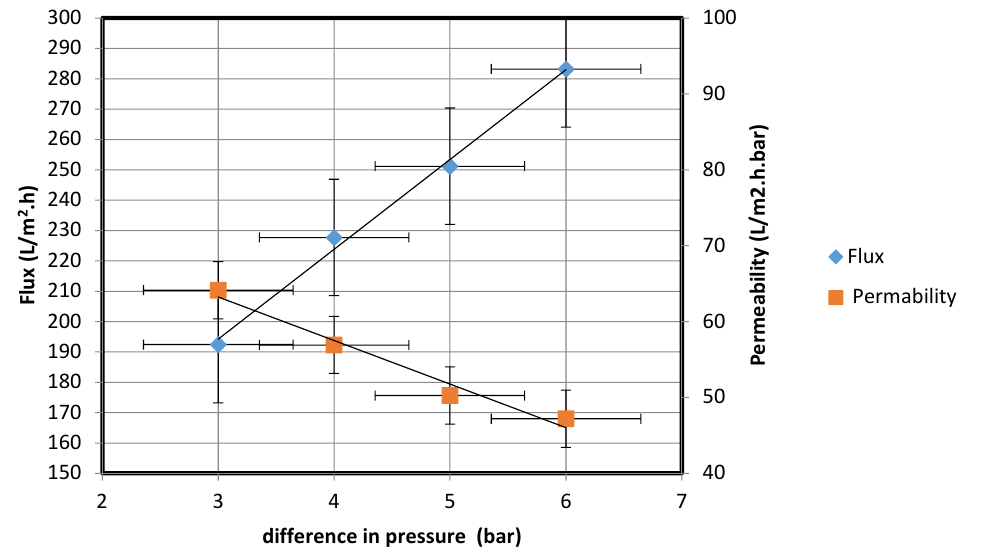
Figure 11. Water flux rate and permeability of fabricated membrane at different pressures.